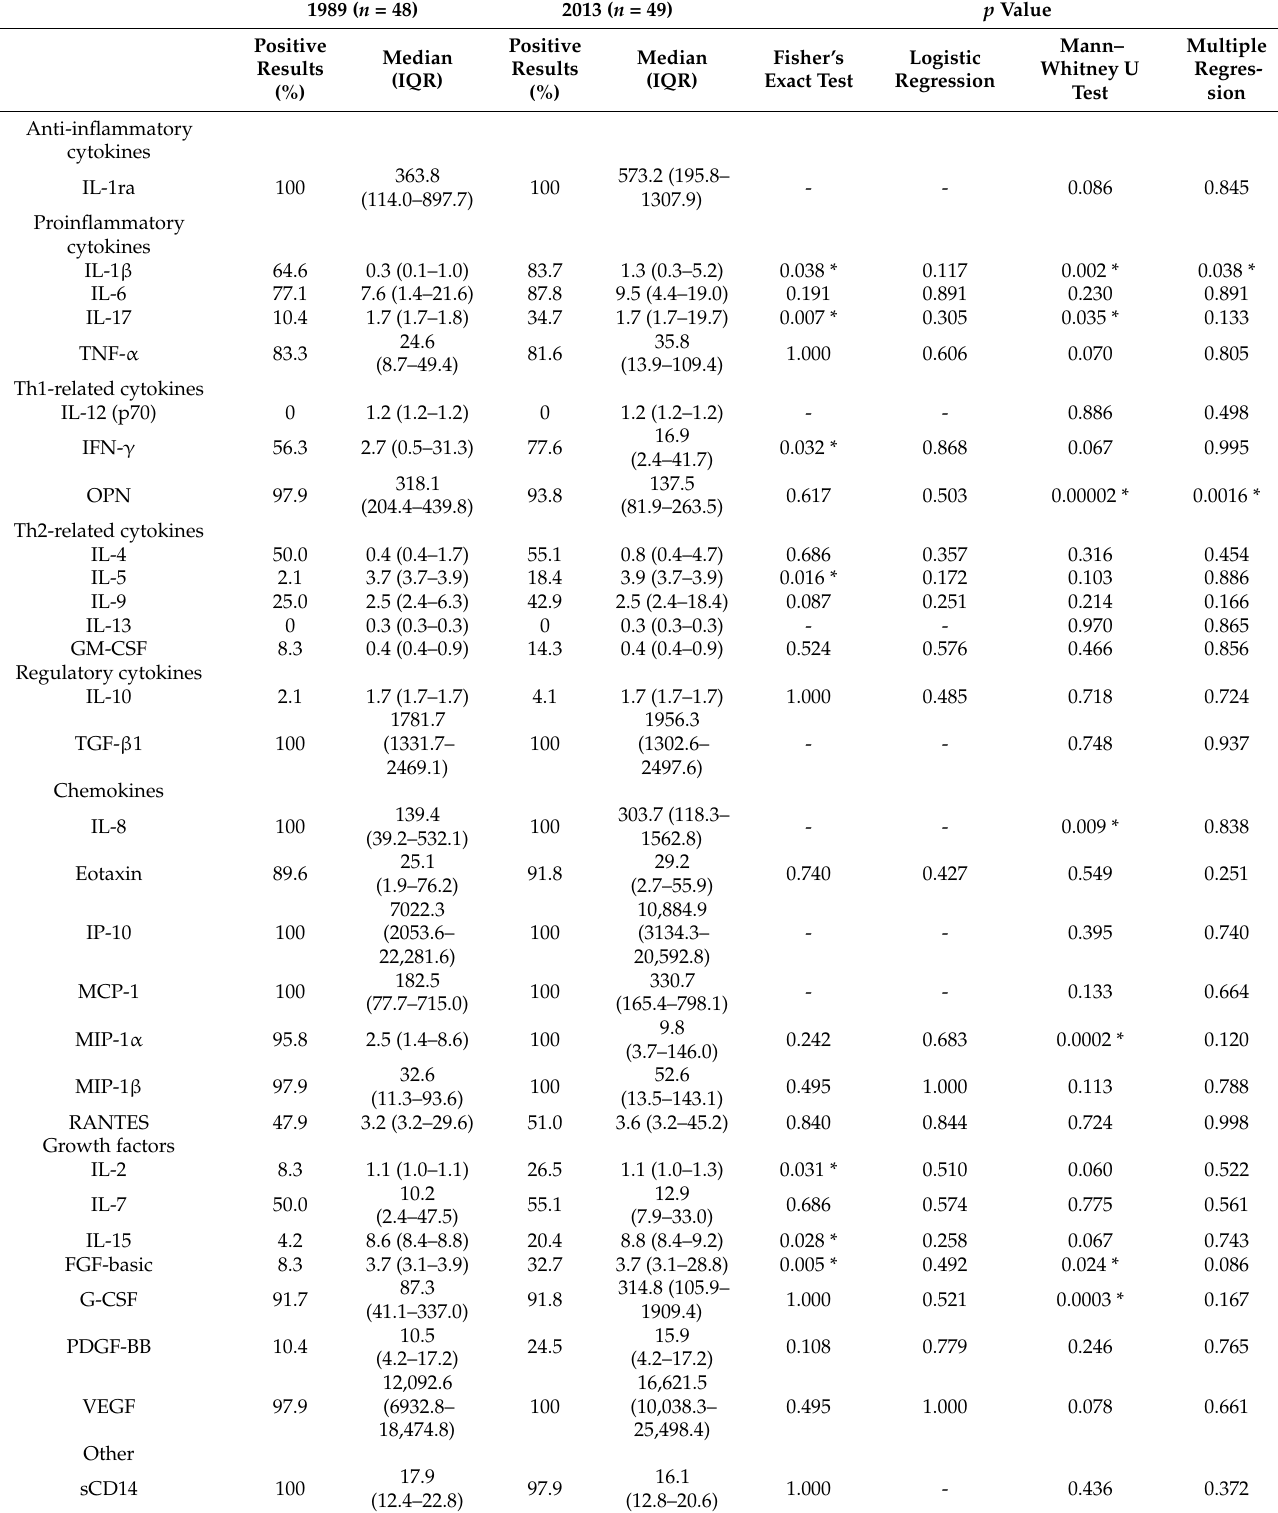
Table 2. Cytokine profile in the C